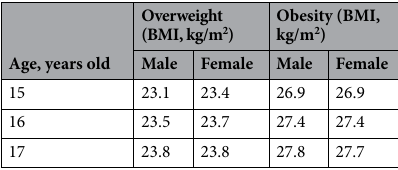
Table 1. Guidelines for the prevention and control of overweight and obesity in school-age children in